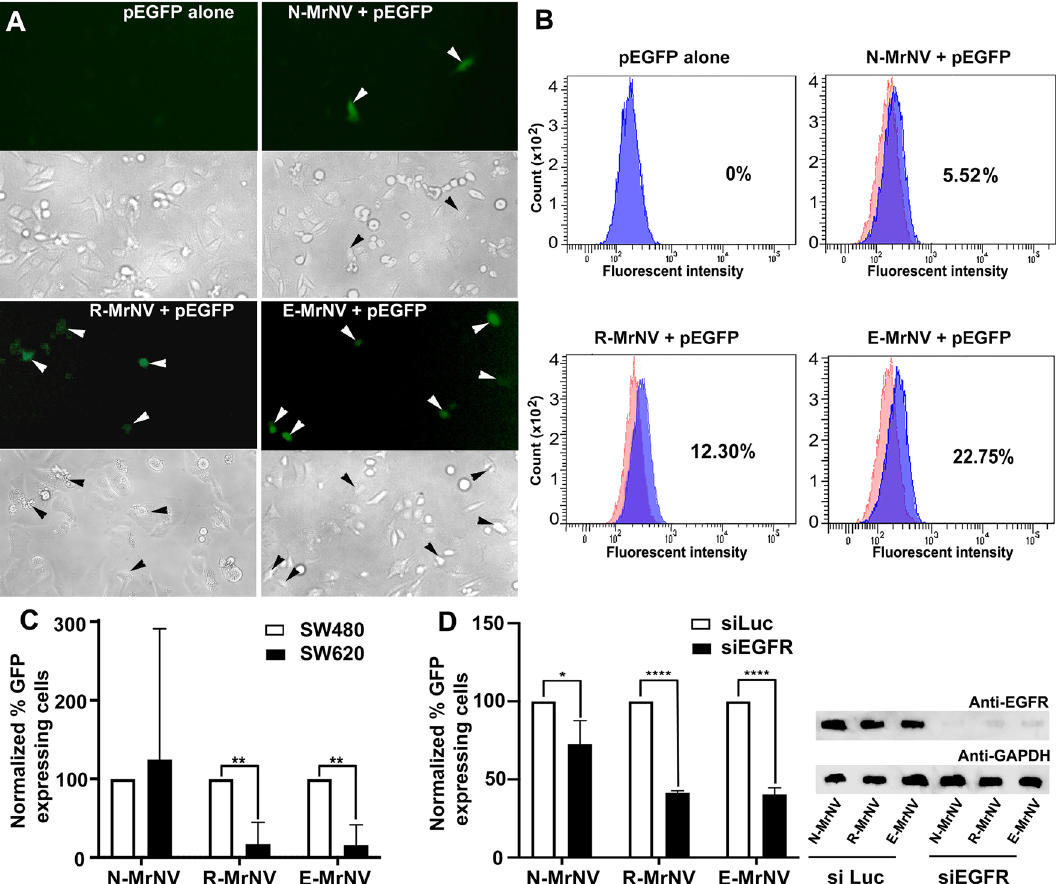
Figure 6. Chimeric MrNV-VLPs delivered encapsulated EGFP plasmid specifically to EGFR-positive cells. Both EGFR-positive colorectal cancer cells (SW480) and EGFR-negative cells (SW620) were incubated with MrNV VLPs carrying its cargo, encapsulated EGFP plasmid, and were left further to allow GFP protein expression for 48 h. The cells were then either visualized by confocal microscopy (panel A ) or flow cytometry (panel B ). Flow cytometric analyses of GFP expression in SW480 and SW620 cells (panel C ) or those treated with siRNA against EGFR or luciferase (siLuc, control) in SW480 cells (panel D ; right, typical EGFR knockdown level shown by